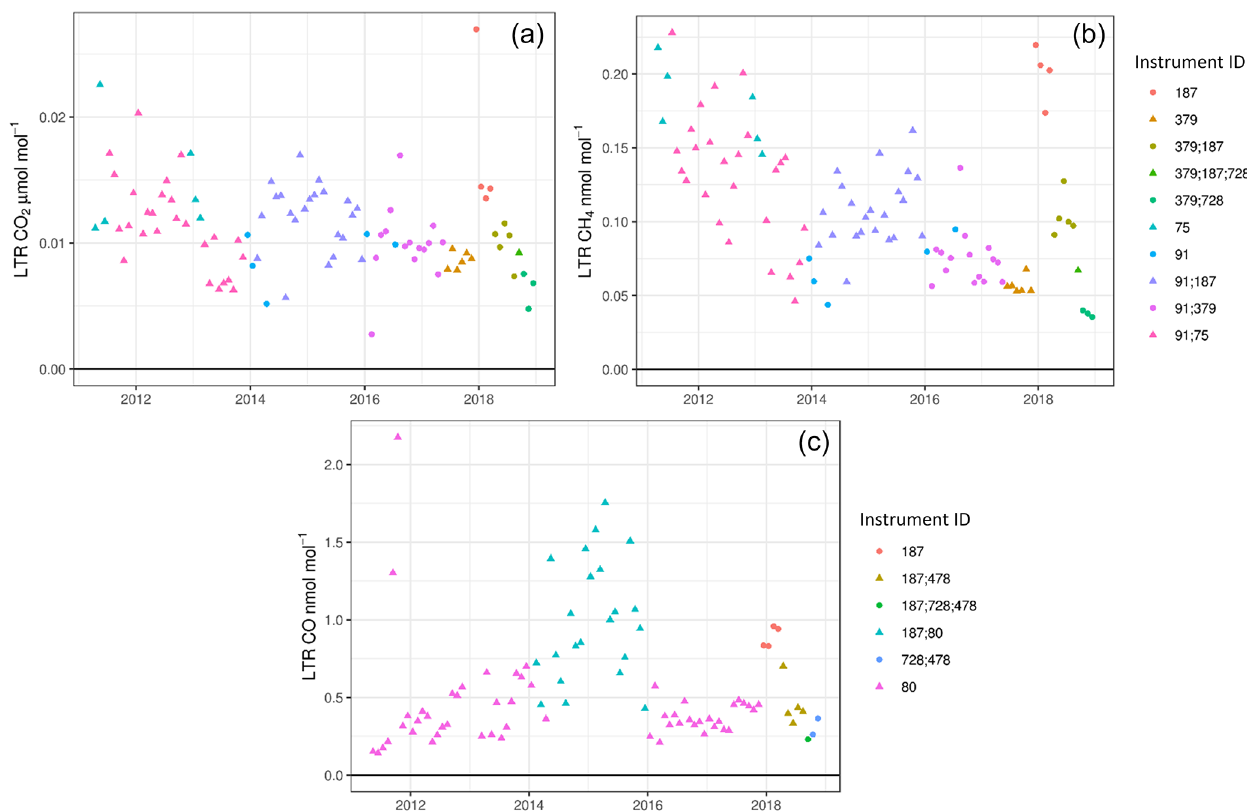
Figure 7. Monthly mean field long-term repeatability (LTR) for CO 2 (a) , CH 4 (b) and CO (c) estimated over time for the different instruments in operation at the OPE station over the 2011–2018 period. The different instruments are shown in colour and their identifiers are labelled in the keys of the top and bottom panels. Some months have several instruments running at the station and these are identified with several